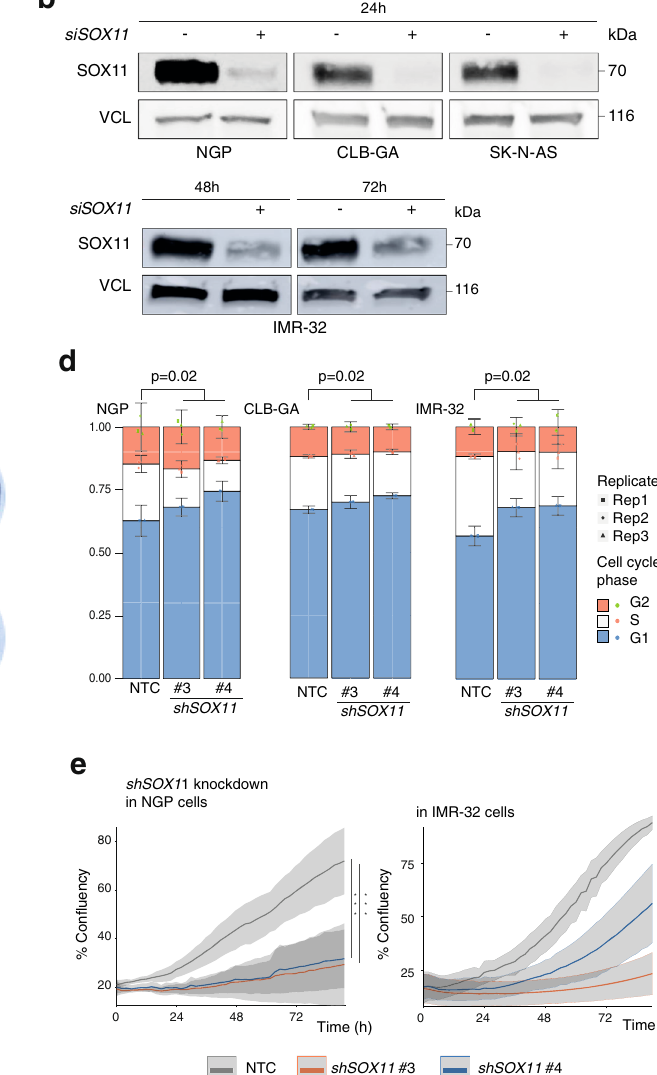
Fig. 3a – e, source data are provided as Source Data fi